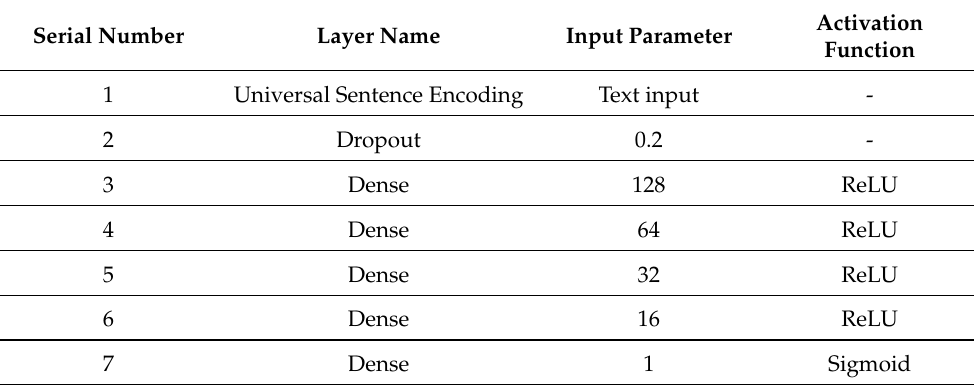
Table 2. USE-Based proposed deep neural